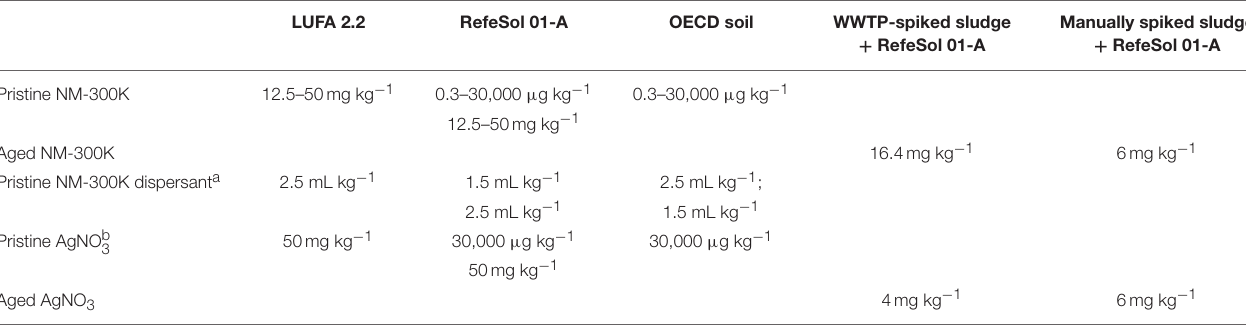
TABLE 2 | Summary of the treatments applied in 28- day Collembola reproduction tests (50% WHC max, 20 ◦ C, n =